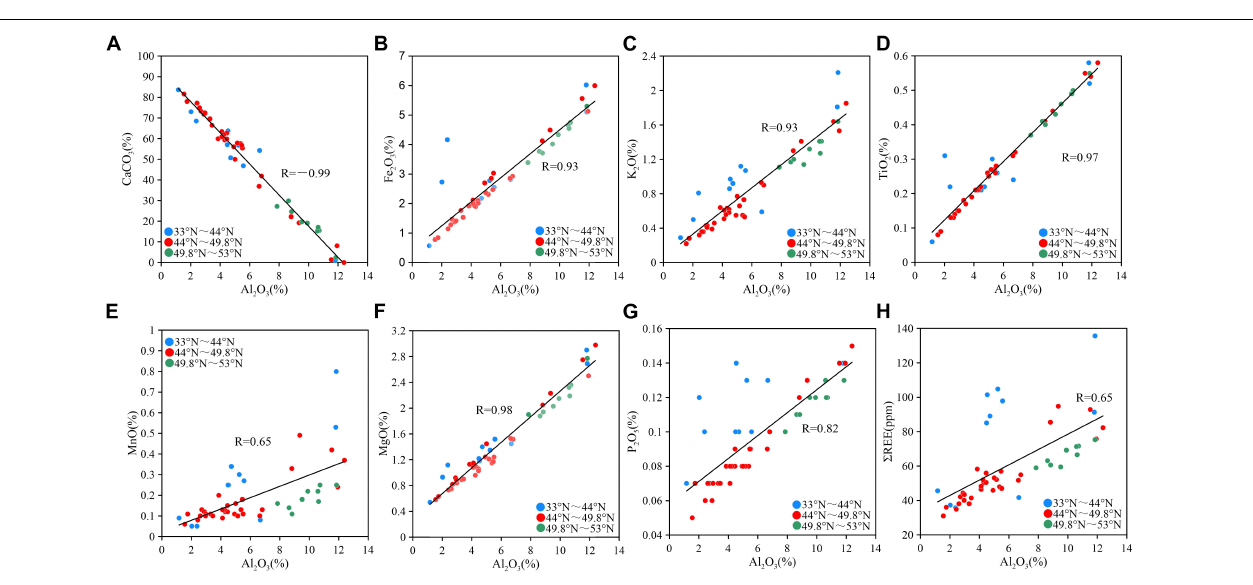
FIGURE 6 | The scatter plots between Al 2 O 3 and other elements. The correlation between CaCO 3 and Al 2 O 3 ( R = − 0.99, A ), the correlation between Fe 2 O 3 and Al 2 O 3 ( R = 0.93, B ), the correlation between K 2 O and Al 2 O 3 ( R = 0.93, C ), the correlation between TiO 2 and Al 2 O 3 ( R = 0.97, D ), the correlation between MnO and Al 2 O 3 ( R = 0.65, E ), the correlation between MgO and Al 2 O 3 ( R = 0.98, F ), the correlation between P 2 O 5 and Al 2 O 3 ( R = 0.82, G ) and the correlation between (cid:54) REE and Al 2 O 3 ( R = 0.65, H